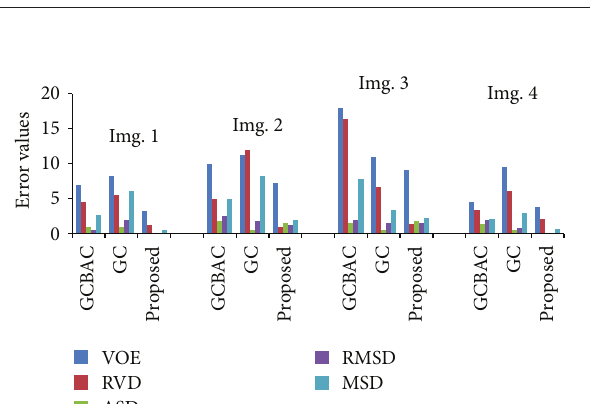
Figure 6: Performance comparison between three